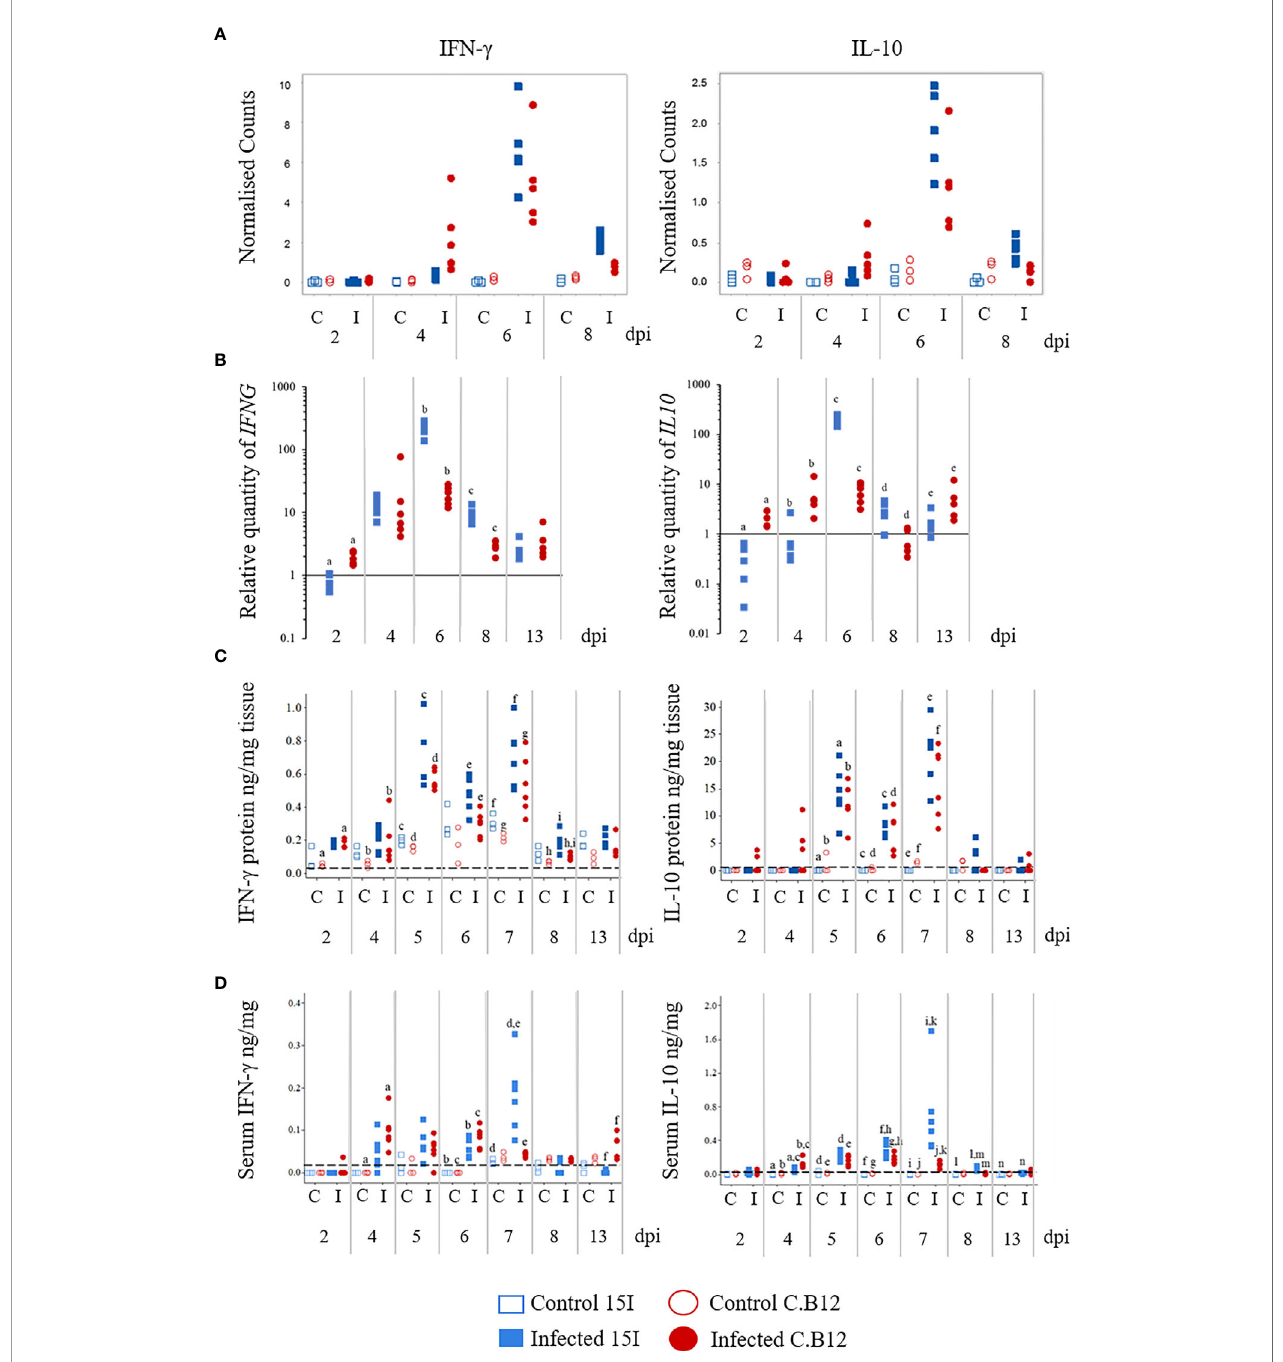
FIGURE 5 | Kinetics of IFNG and IL10 mRNA transcription by RNA-Seq (A) and RT-qPCR (B) , protein levels in the jejunum (C) and protein levels in the serum (D) of E. maxima -infected chickens. Three-week old birds were orally inoculated with 100 oocysts of E. maxima (solid markers) or sterile water (control birds; hollow markers) and jejunum and serum samples collected at various days post-infection as indicated. Data are presented as individual birds. For RT-qPCR data, the relative quantity (RQ) of mRNA transcription of individual infected birds was calculated relative to the mean of control birds of the same line at individual time points and normalized using the 28S reference gene. Matching letters denote signi fi cant differences between groups on the same day ( p < 0.05, n = 3 for control and n = 5 for infected groups). C, control; I, infected; Line C.B12 shown as red circles, line 15I as blue